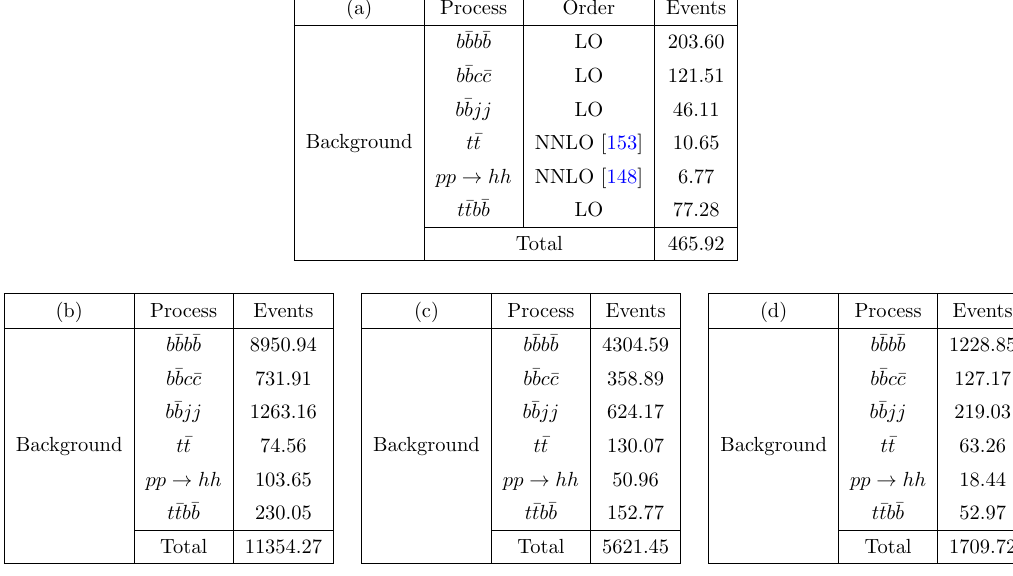
Table 9 . Respective background yields for the b (cid:22) bb (cid:22) b channel after the BDT analyses optimised for a heavy Higgs mass of ( a ) 400 GeV, ( b ) 600 GeV, ( c ) 800 GeV and ( d ) 1 TeV. The tables also list the perturbative order at which the cross-sections are considered.